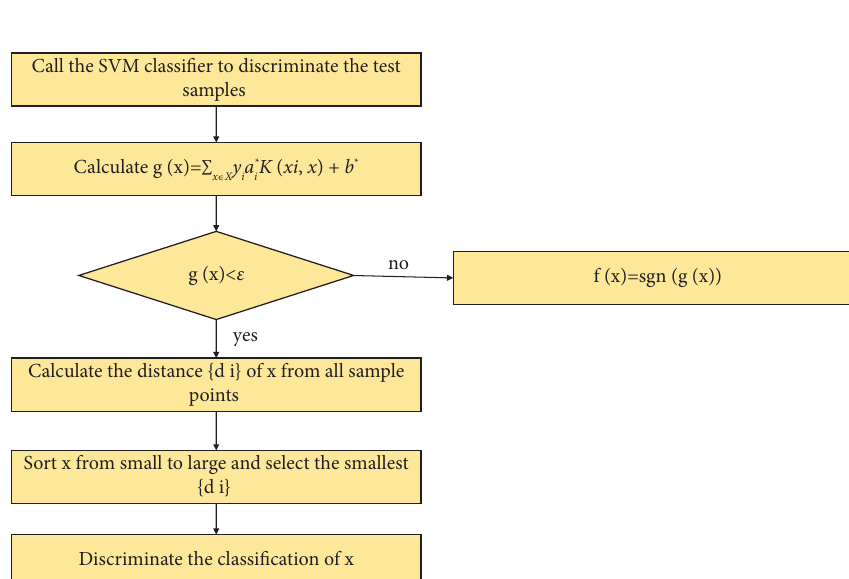
Figure 2: Te improved fow chart of the test sample discrimination method.